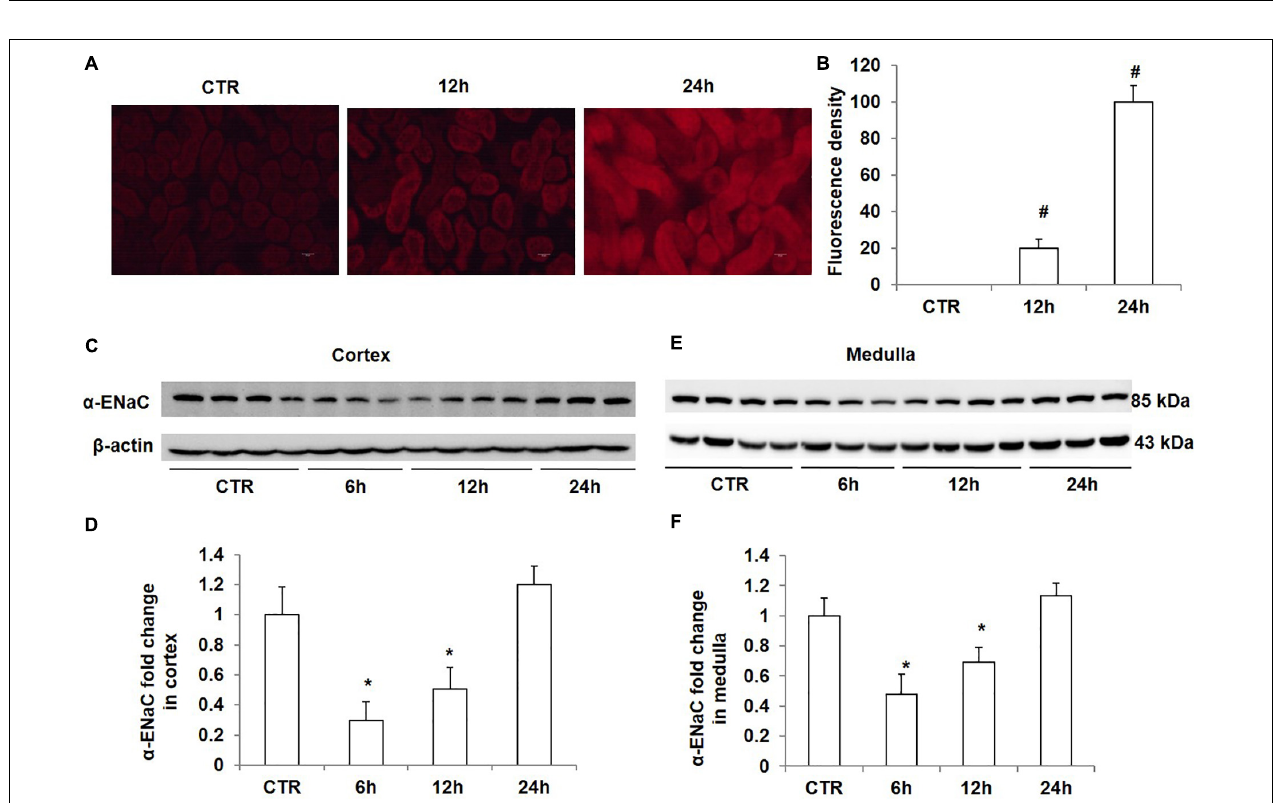
FIGURE 4 | Time course analysis of ROS generation and α -ENaC protein expression in kidneys after acute high salt loading. (A) ROS levels were examined with DHE in the kidney after salt loading for 12 and 24 h. (B) Quantification of DHE fluorescence intensity in the kidney after salt loading for 12 and 24 h. (C) Western blotting analysis of α -ENaC and β -actin in renal cortex after salt loading for 6, 12, and 24 h. (D) Densitometric analysis of α -ENaC normalized by β -actin in cortex tissue. (E) Western blotting analysis of α -ENaC and β -actin in renal medulla after salt loading for 6, 12, and 24 h. (F) Densitometric analysis of α -ENaC normalized by β -actin in medulla tissue. The presented data are means ± SE. n = 3–4 per group. ∗ p < 0.05 vs. CTR (control); # p < 0.01 vs. CTR (control).